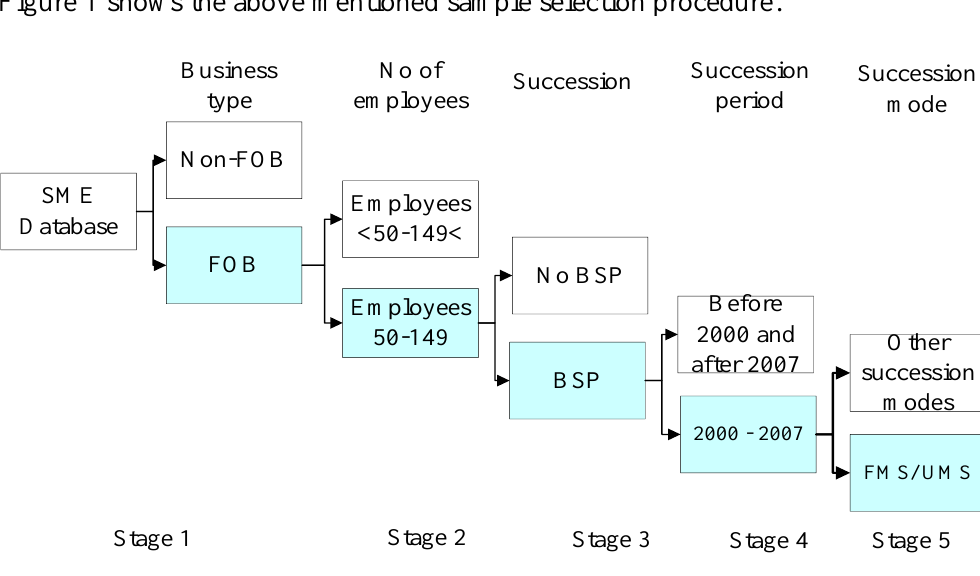
Figure 1: Sorting procedure to identify sample units Source: Designed by the